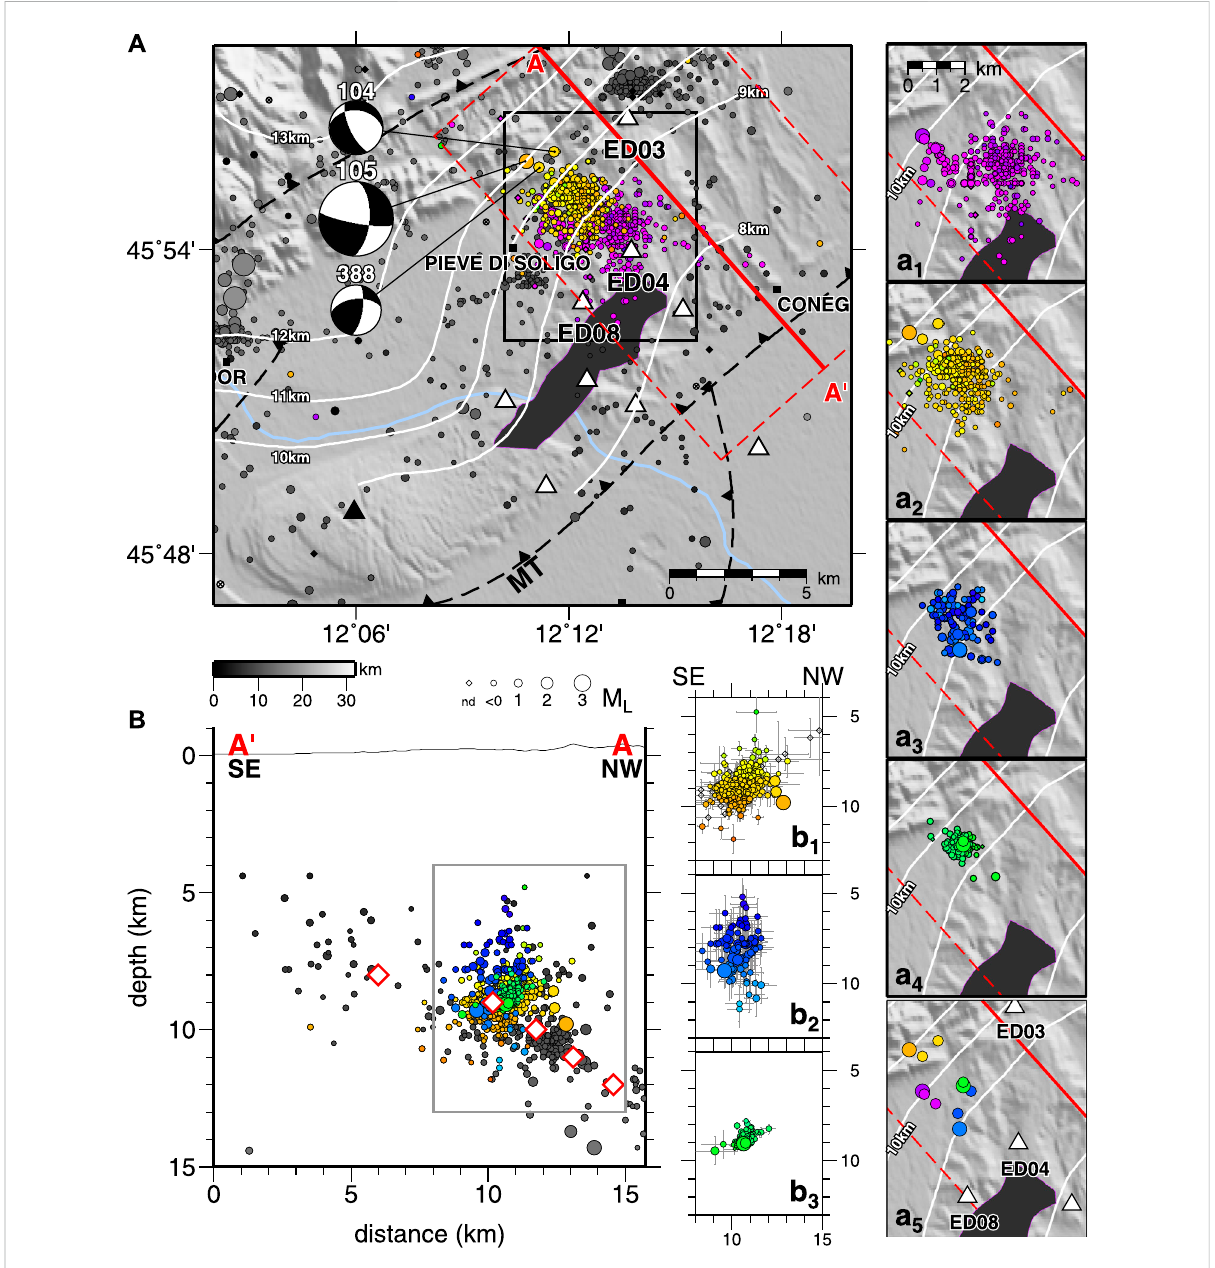
FIGURE 3 Spatial features of the Refrontolo sequence using different location algorithms. (A) Epicentral map of the Refrontolo sequence in August 2021 using H71 (in purple) or HEL (in yellowish colors): the entire HEL catalog of the RSC network from 2012 to October 2021 is shown in the background with gray color palette for depth; beach balls of the three main events with events IDs. White isolines represent the interpolation of the seismogenic horizon interpreted as the Montello Thrust (Romano et al., 2019). Other symbols as in Figure 1. Insets: a1) H71 dataset alone (374 events); a2) HEL dataset (374 events); a3) MigraLoc absolute localizations (97 events); a4) HypoDD relative localizations (229 events); a5) comparisonofepicenterlocationforthethreemaineventslocalizedbydifferentmethods. (B) Cross-sectionofseismicityasabove,alongasectorof the CROP -Transalp pro fi le (see Figure 1). Insets: b1) HEL; b2) MigraLoc; b3) HypoDD. Location errors are shown by thin gray bars; red diamonds are the projection of isolines representing the